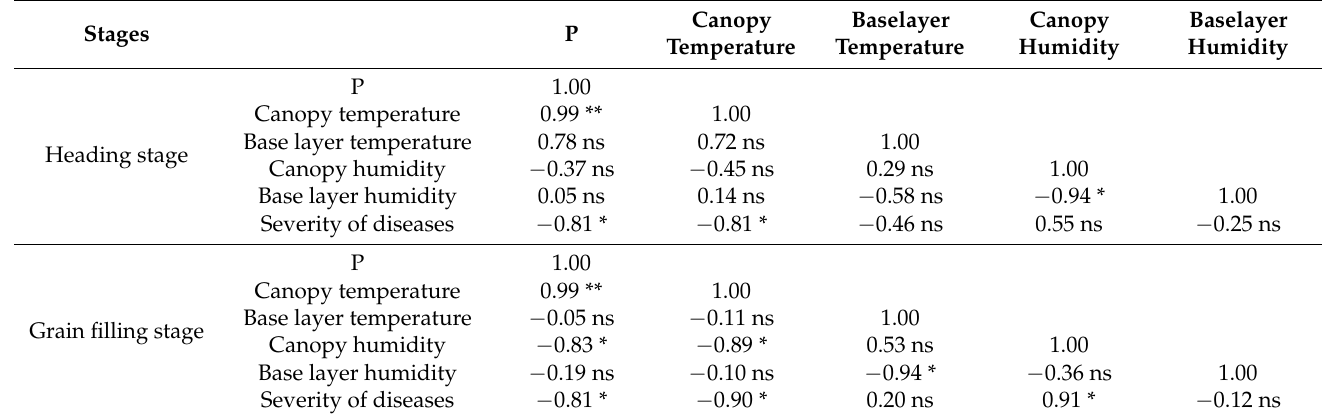
Table 4. Correlation Analysis among P application rate, population temperature, humidity, and sheath